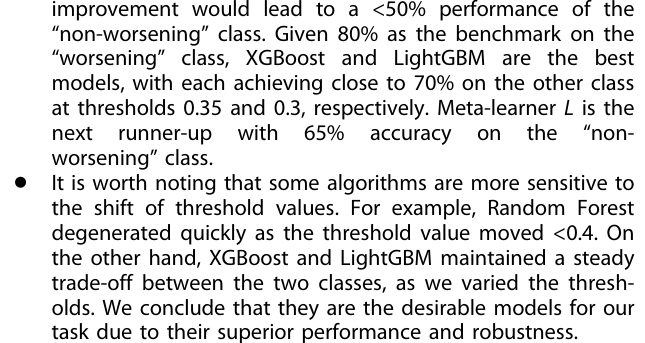
Table 2 presents the validation results of our models using the EPIC dataset. To facilitate a validation from a dataset with different variables and data frequency, we rebuilt our models using the CLIMB dataset, but with only the overlapping attributes of the two datasets and with annual observations. The resulting models were applied directly to the EPIC dataset to evaluate the ef fi cacy of our models. We fi rst observe that, similar to Table 1, ensemble